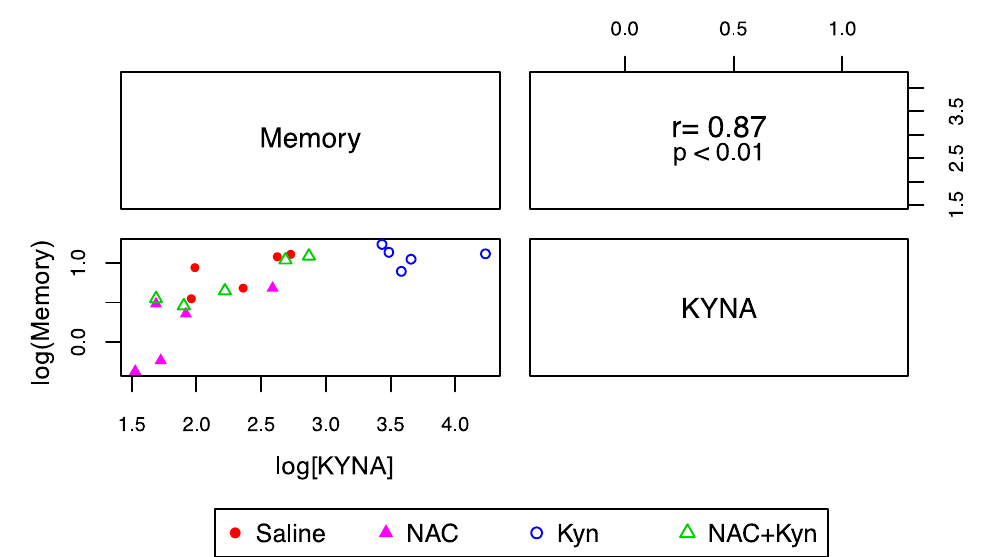
Figure 6. Correlation between KYNA levels and memory performance. The lower triangular matrix contains the scatterplot for KYNA (fmoles/mg tissue) and the time (seconds) the animal spends to find the target (memory). The upper triangular matrix contains the Spearman’s rank correlation coefficient (r) and its associated p -value ( p ) ( n = 5 per group).